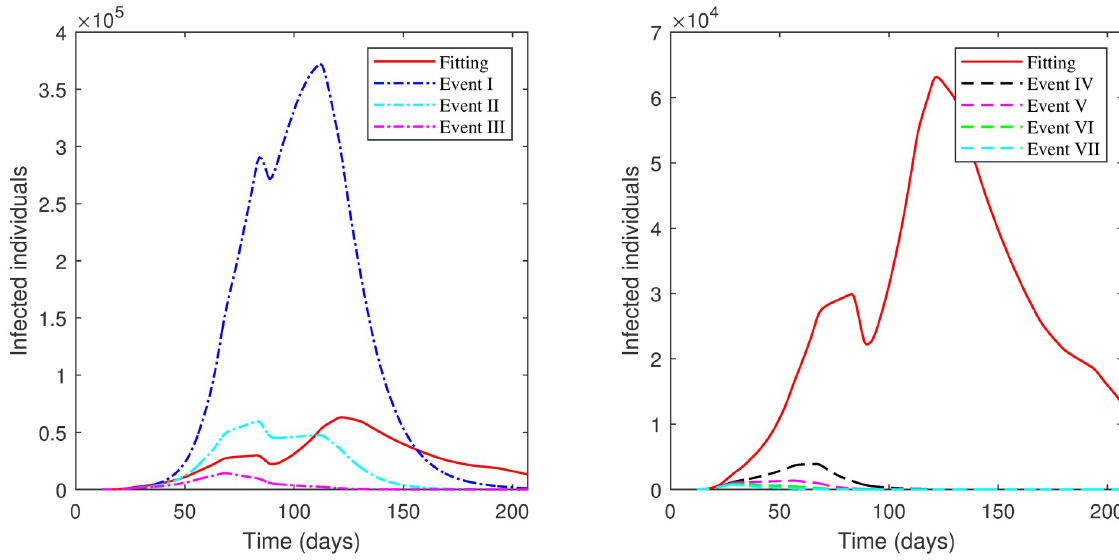
Fig 15. Numerical solution of model (1) for infected compartment vs. time for 3 rd scenario of Second